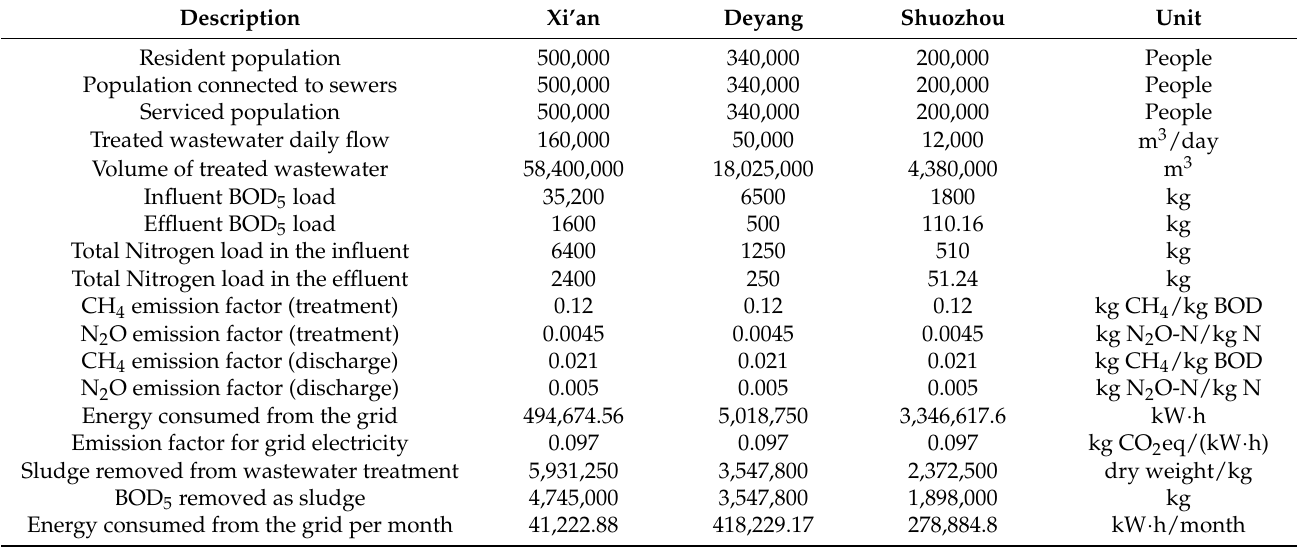
Table 2. The initial GHG evaluation stage is input into the ECAM